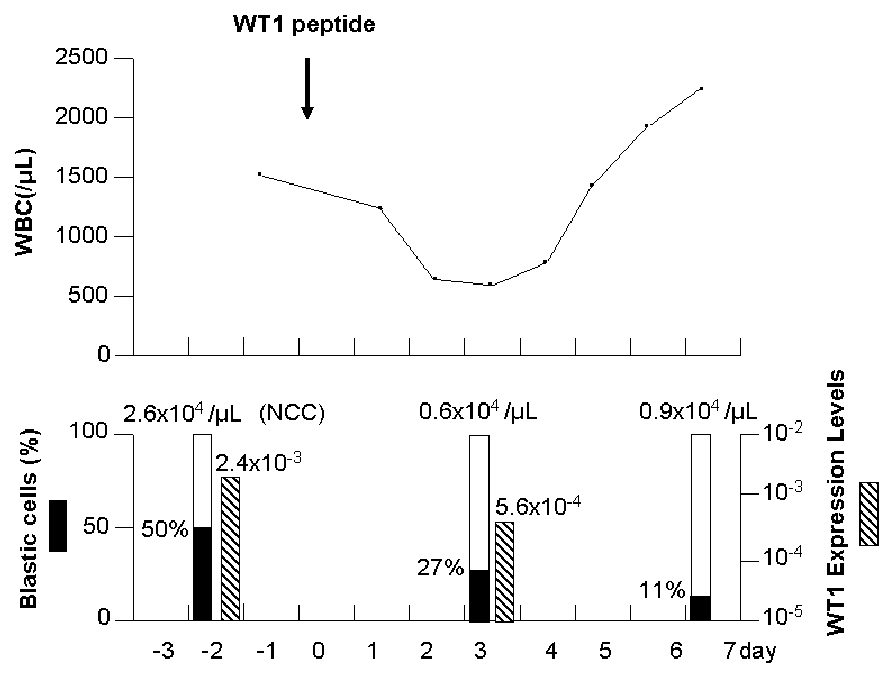
FIGURE 2. Reduction of blast cells and WT1 expression level in bone marrow, concomitant with leukocytopenia, in an MDS-derived AML patient treated with the WT1 peptide vaccination. Speculation for mechanism of the simultaneous occurrence of leukemic blast cell reduction and leukocytopenia is described in the text. WBC count was recovered by administration of G-CSF and steroid to stop the vaccination- mediated immune reaction. NCC: nucleated cell count. This figure was modified from that in Oka, Y. et al. (2003) Int. J. Hematol . 78, 56 − 61.